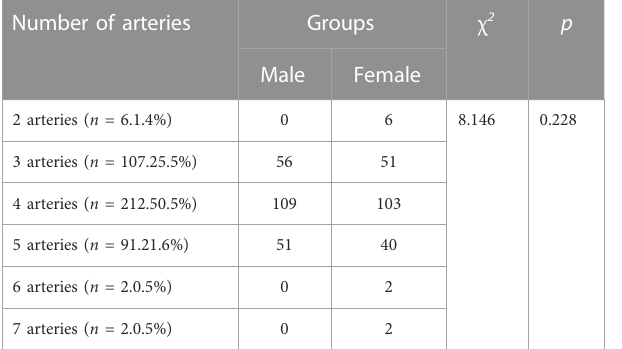
TABLE 2 Characteristics of left superior pulmonary artery.